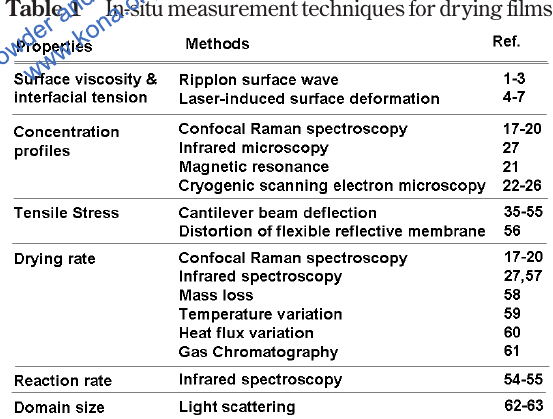
Table 1 In-situ measurement techniques for drying films